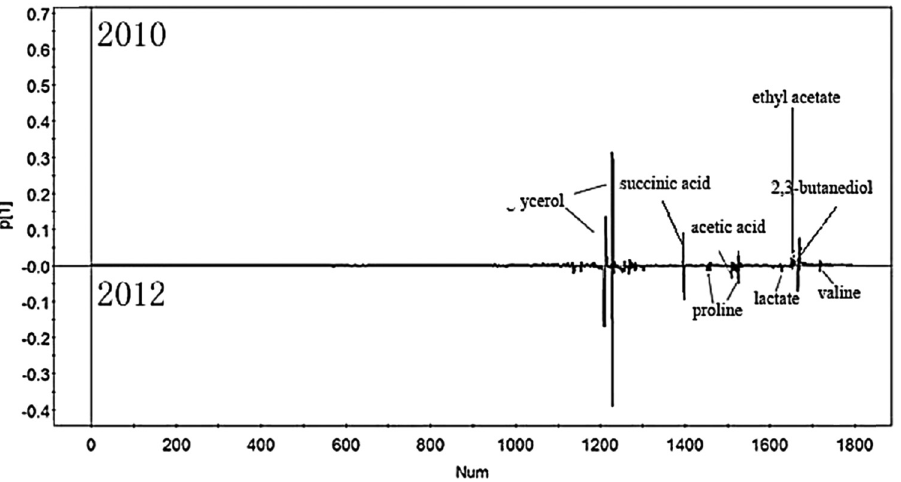
Figure 17: PLS - DA loading plot chart from 1 H NMR spectra of 2010 and 2012 vintage Cabernet Sauvignon wines.